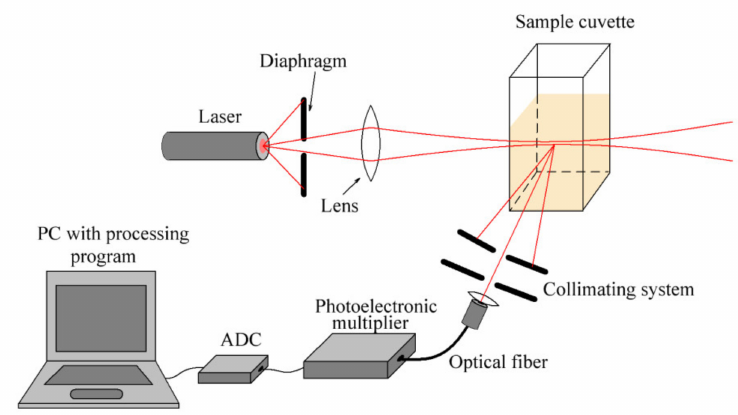
Figure 1. Scheme of the laser correlation